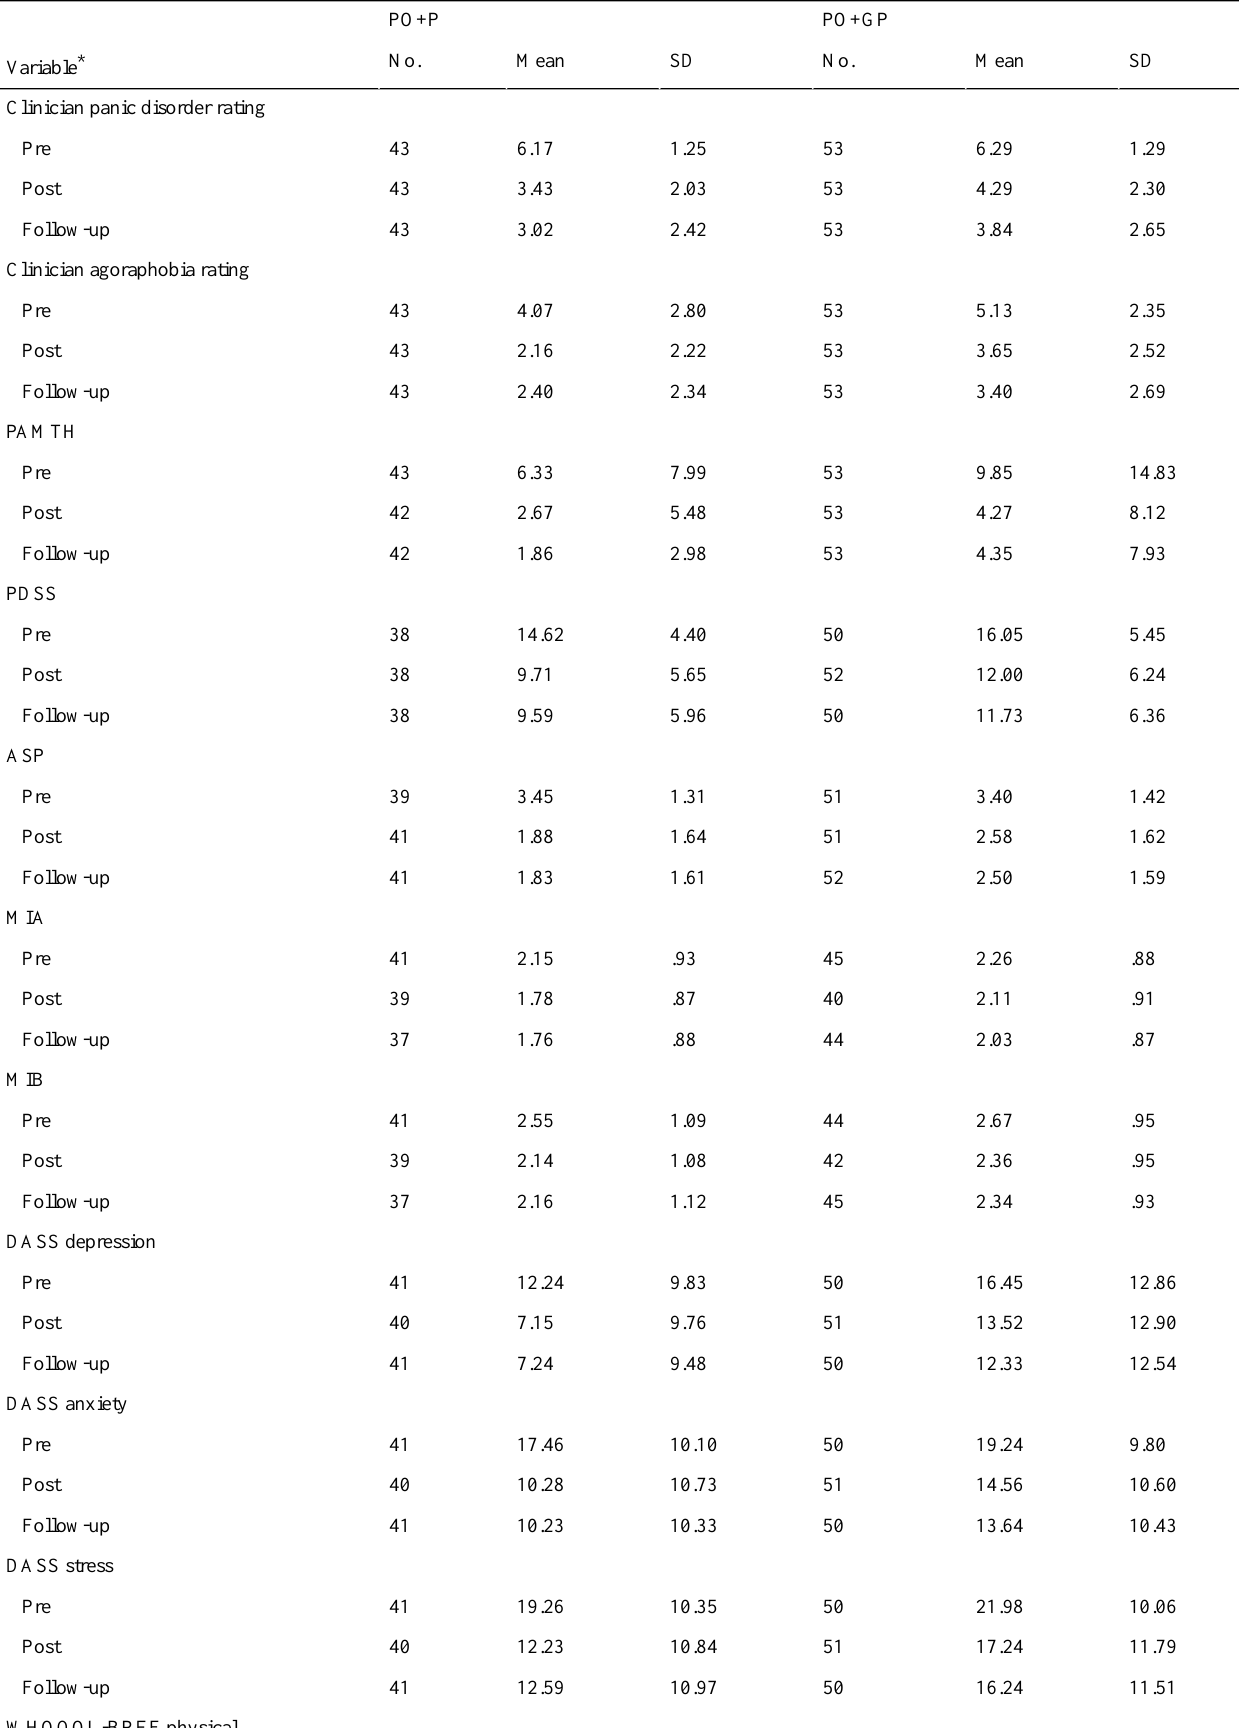
Table 6. Means and standard deviations for treatment outcome measures at pretreatment, posttreatment, and follow-up treatment assessments, by